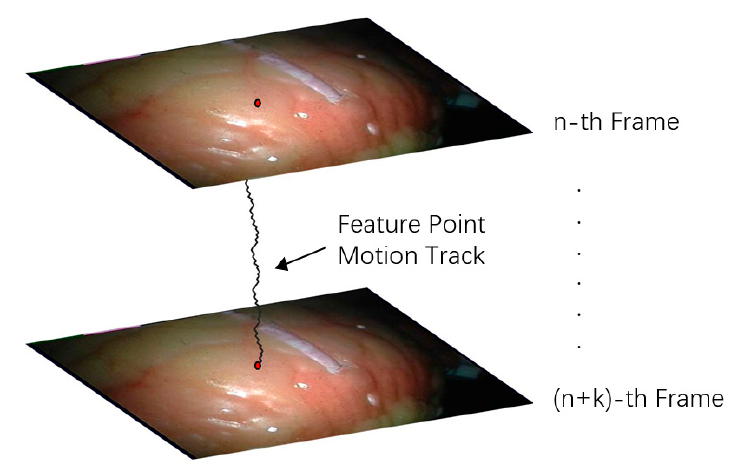
Figure 10. Feature point tracking diagram.